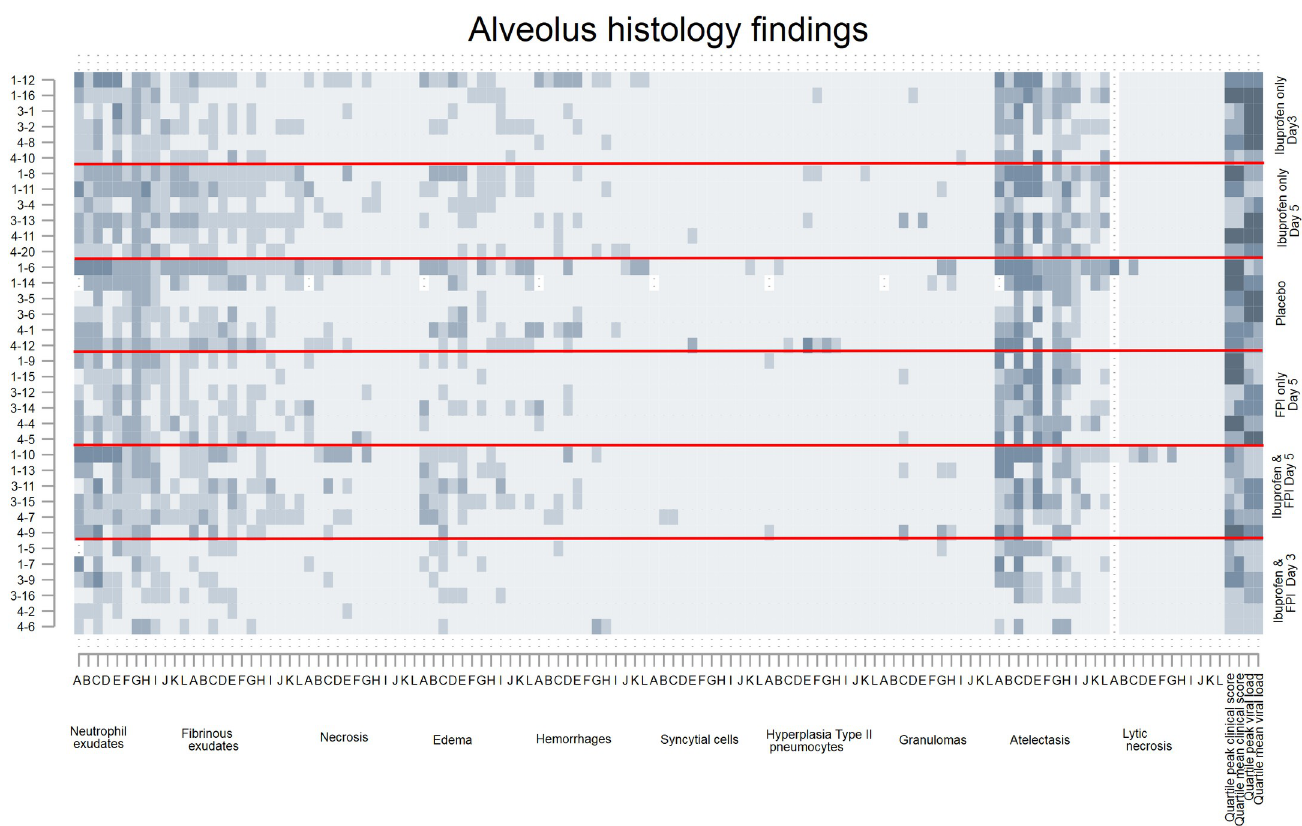
Fig 3. Alveolus histology findings by drug treatment group. Each row represents an individual calf, each letter represents a slide, the x-axis colors indicate a different specific histological finding. The shading of each pixel represents the severity of the finding on a scale of 0 (light) to 3 (darker). On the y-axis the first number represents the batch/replicate number, the number following the dash the ear tag for the individual calf. The horizontal red lines divide the treatment groups. The last four columns represent quartiles (first lightest, fourth darkest) of mean peak and clinical scores and mean peak viral loads measured by nasal swabs.